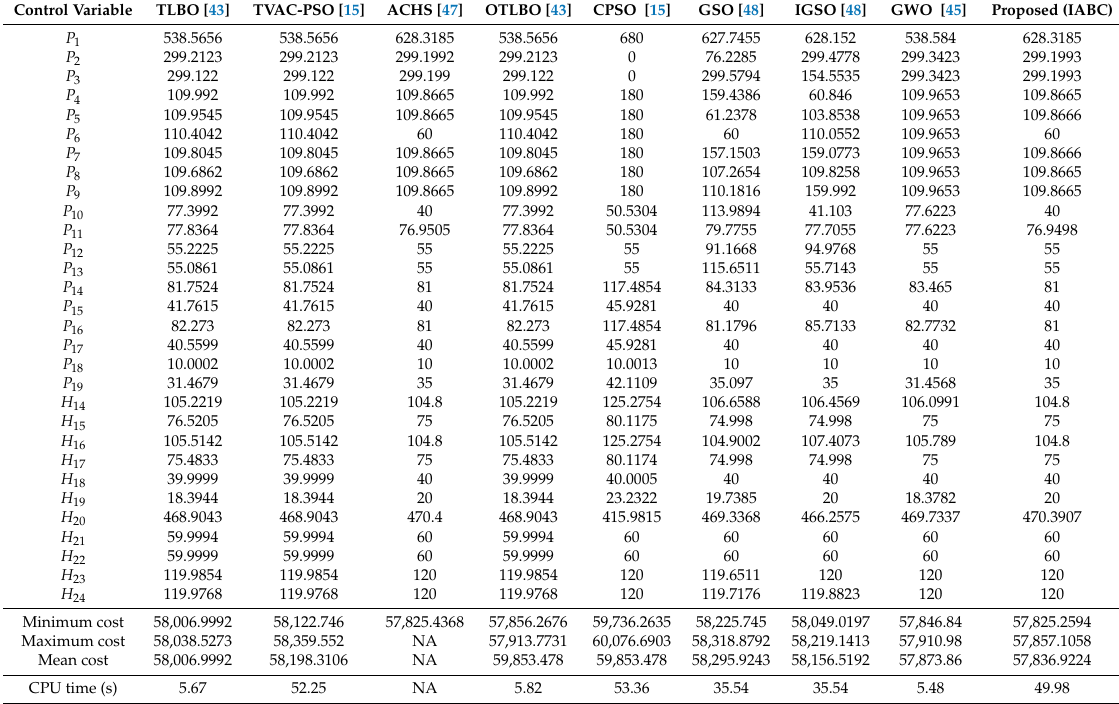
Table 11. Comparison of the obtained results for 24-unit test